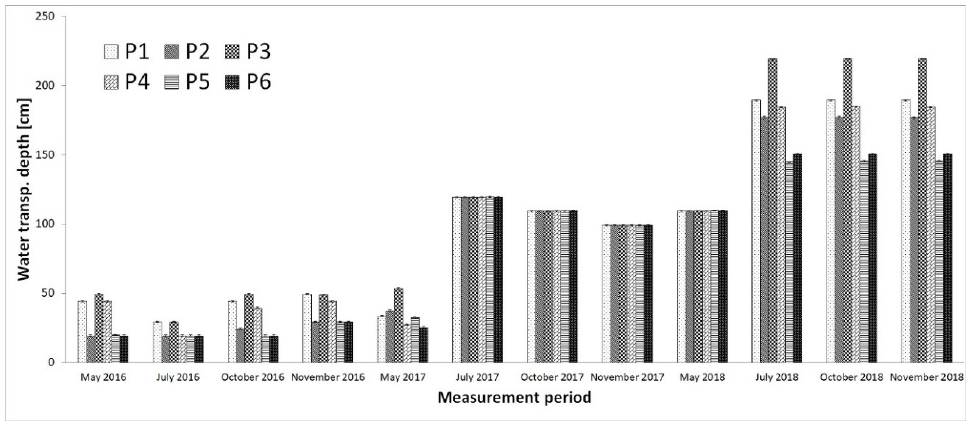
Figure 5. Changes in water transparency in the years 2016–2018, measured with a Secchi disk.